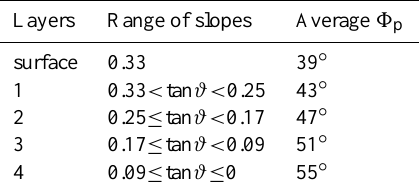
Table 3. Description and average peak friction angle 8 p (represen- tative of the three materials A, B, C) for the embankment layers, identified through the downstream embankment slopes tan ϑ